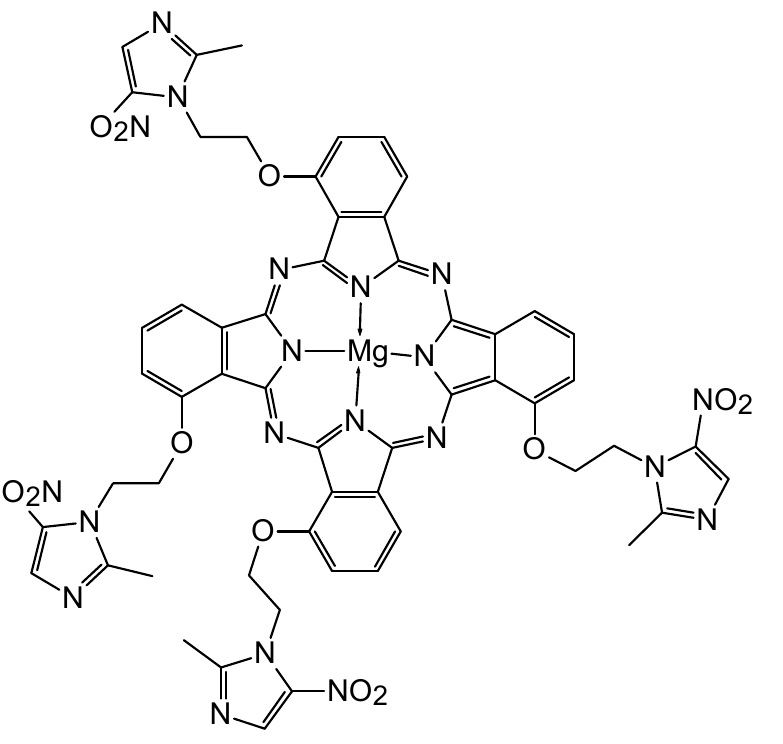
Figure 5. Structure of IV .